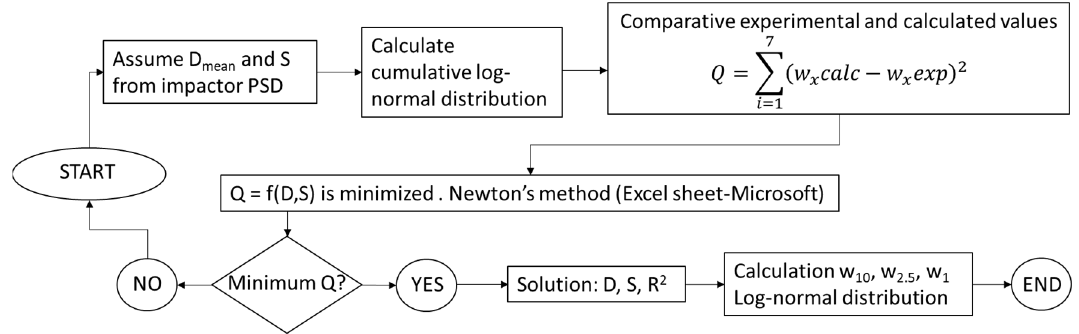
Figure 3. Flow chart of the mathematical treatment used to calculate PSD and w x . D: geometric diameter (µm); S: geometric deviation; R: correlation index.